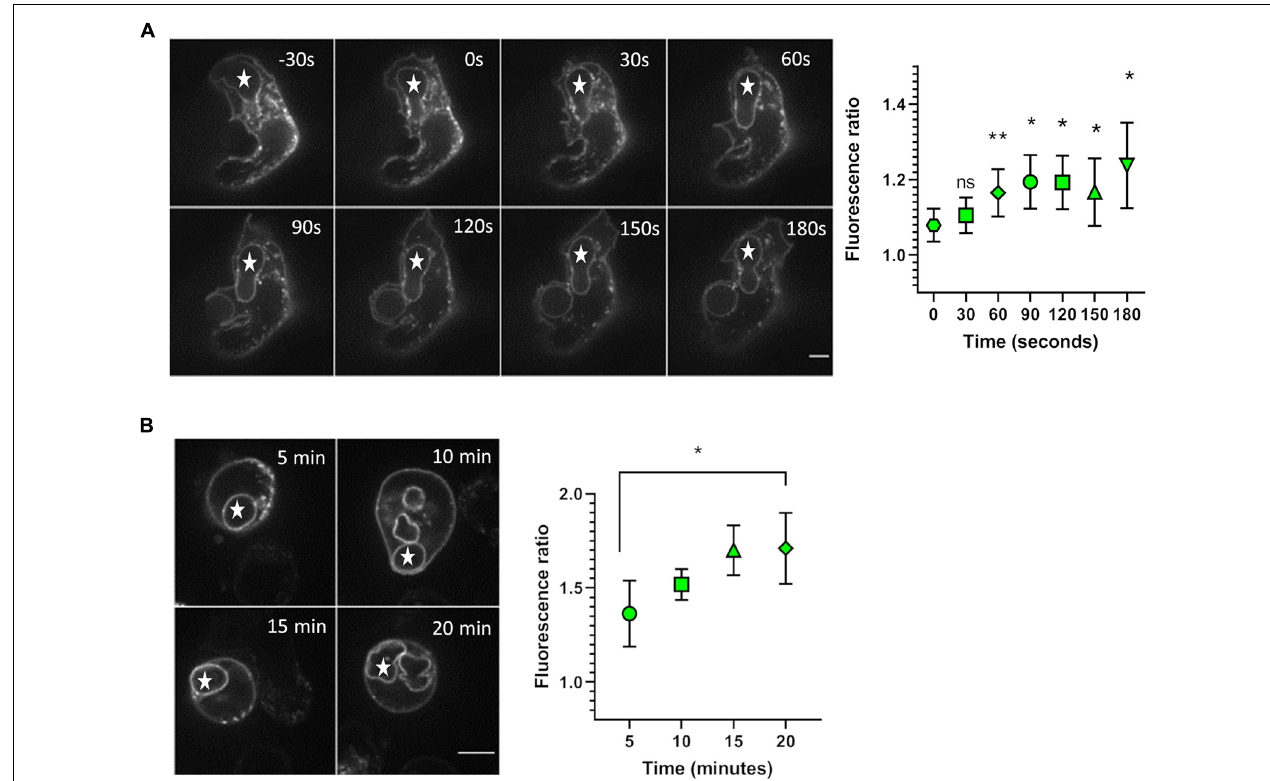
FIGURE 1 | Accumulation of NOX2 in the phagosomal membrane. (A) X 0 -CGD PLB-985 GFP-NOX2 cells were incubated with opsonized zymosan and the phagocytosis was observed by spinning disk confocal video-microscopy. Left: representative images of zymosan (*) phagocytosis at the indicated times. Time 0 represents the closure of the phagosome. The images shown are single planes from a Z-stack. Scale bar = 5 µ m. Right: kinetics of NOX2 accumulation at the phagosome. The fluorescence ratio represents the ratio of NOX2 fluorescence intensity at the phagosome to that at the plasma membrane. Data are means ± SEM. Nineteen videos were analyzed from three independent experiments, * p < 0.05, ** p < 0.01 (ratio paired t -test comparing value at the indicated time with that at time 0). (B) X 0 -CGD PLB-985 GFP-NOX2 cells were incubated with opsonized zymosan and immediately centrifuged at 13 ◦ C. The end of centrifugation corresponds to time 0. Phagocytosis was then observed, at 37 ◦ C, using spinning disk confocal microscopy, a Z-stack was taken every 5 min. Left: representative images of zymosan (*) phagocytosis. The images shown are single planes from a Z-stack. Scale bar = 5 µ m. Right: kinetics of NOX2 accumulation at the phagosome between 5 and 20 min. Data are means ± SEM. Sixteen cells were analyzed from four independent experiments, * p < 0.05 (ratio paired t -test).